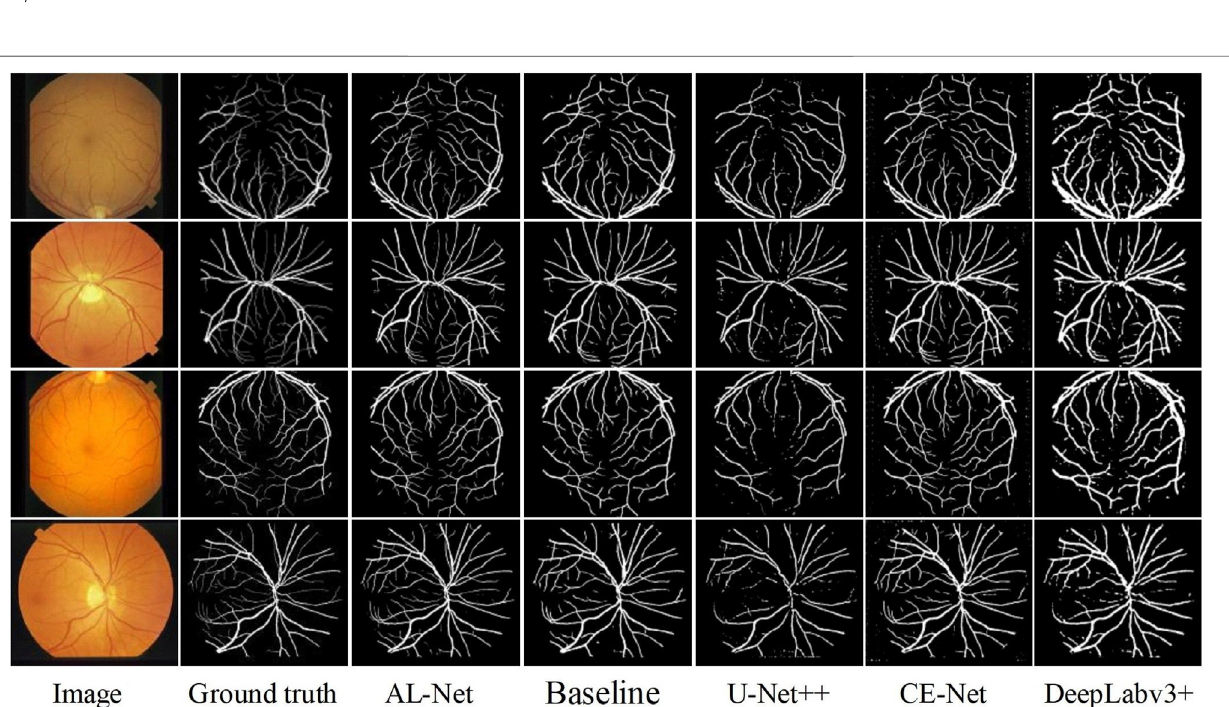
Bold represents the best result.